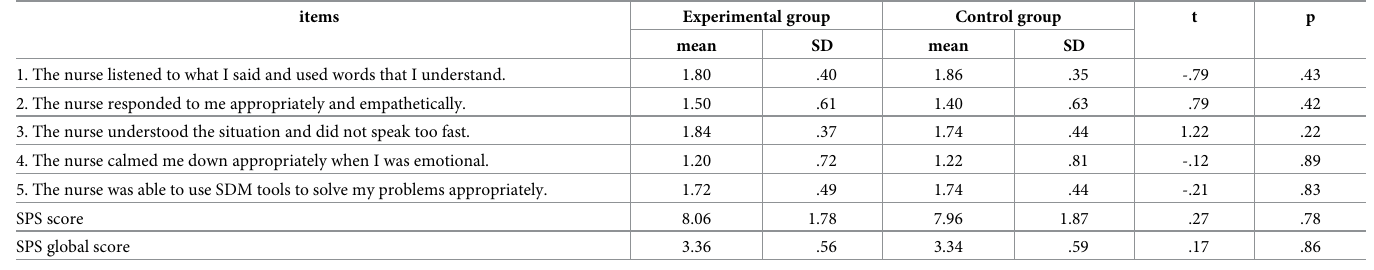
Table 3. The between-group comparisons of SPS scores.